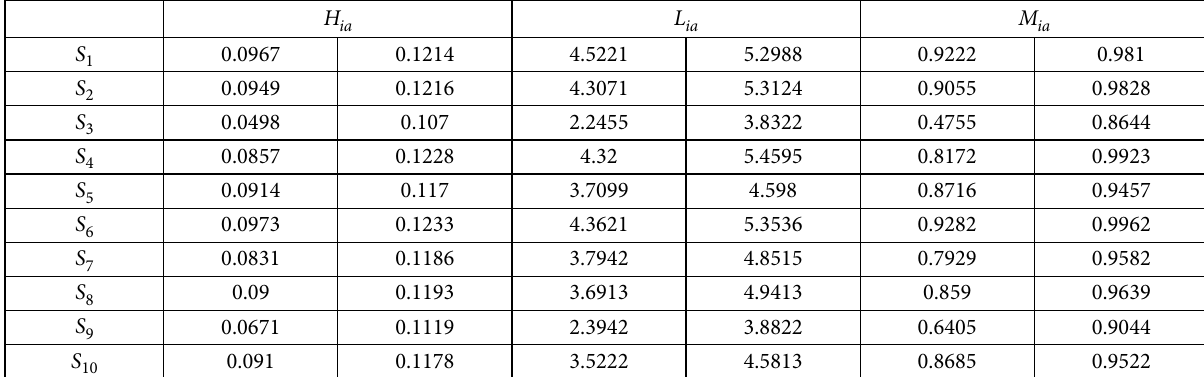
Table 14. Computing the relative weights of the alternatives